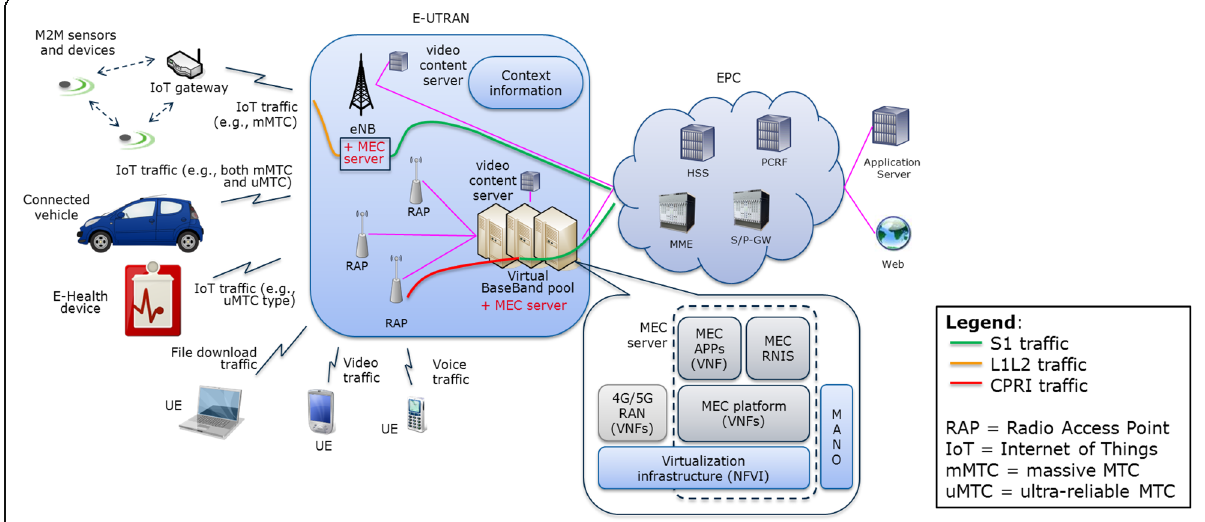
Fig. 1 Exemplary representation of the considered 5G reference